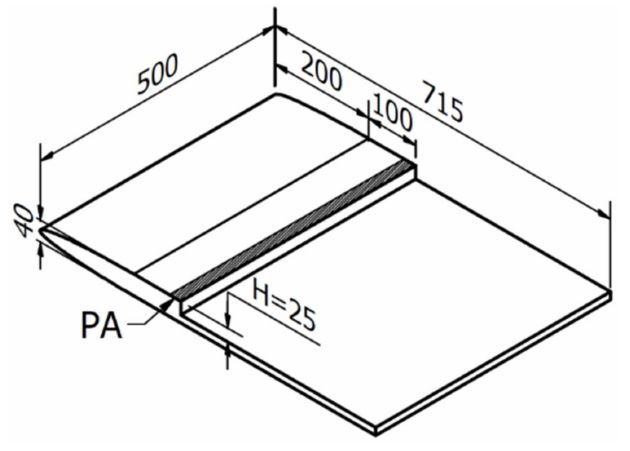
Figure 6. Standard model.